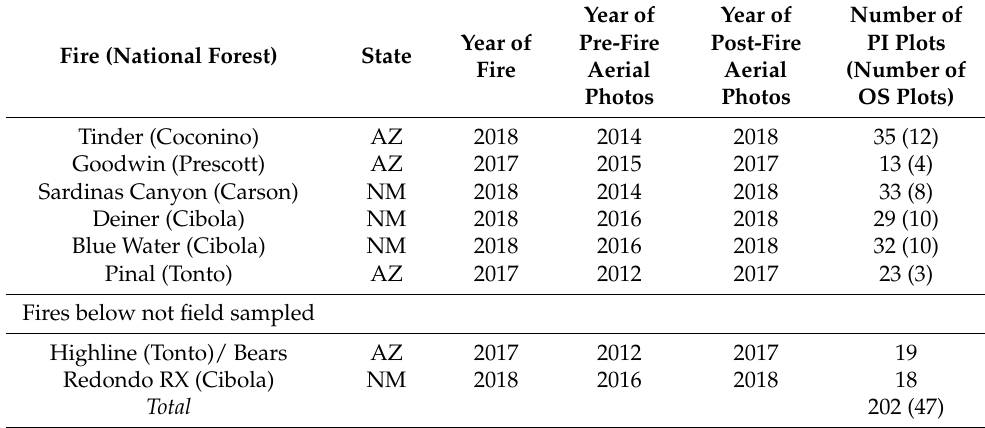
Table 4. Fires sampled, dates of fire, and pre- and post-fire aerial photos.